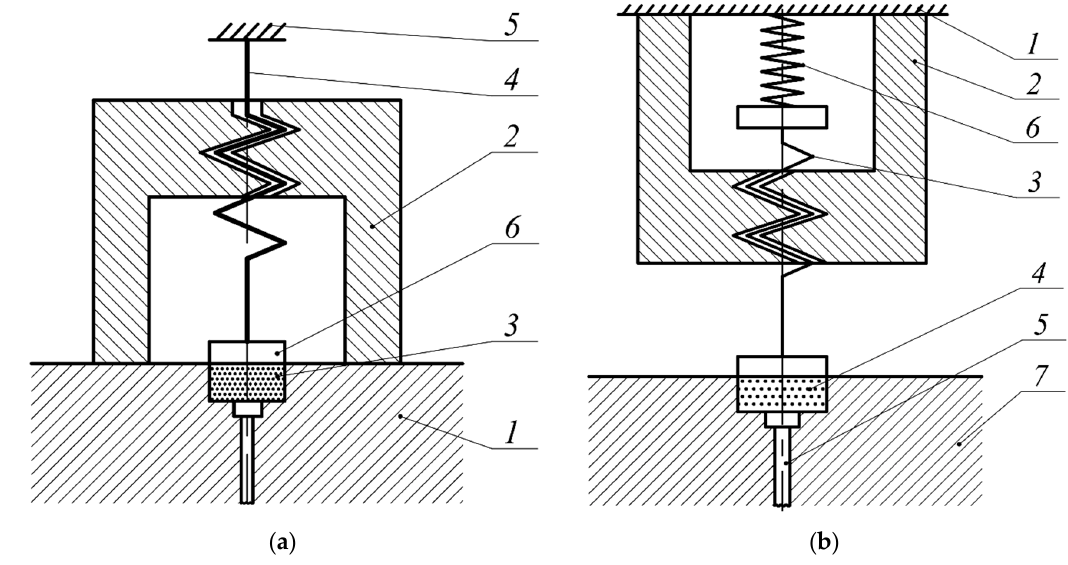
Figure 4. Stamp for powder forming with the creation of shear stress τ on the powder preform surface: ( a ) construction with the effectiveness of pressure power impact of ~ 50–60%, where 1—lower plate; 2—nut; 3—powder; 4—screw; 5—press slider; 6—chisel; ( b ) construction with the effectiveness of pressure power impact of ~90–95 %, where 1—press slider; 2—nut; 3—screw; 4—powder preform; 5—ejector; 6—spring element; 7—bottom plate.